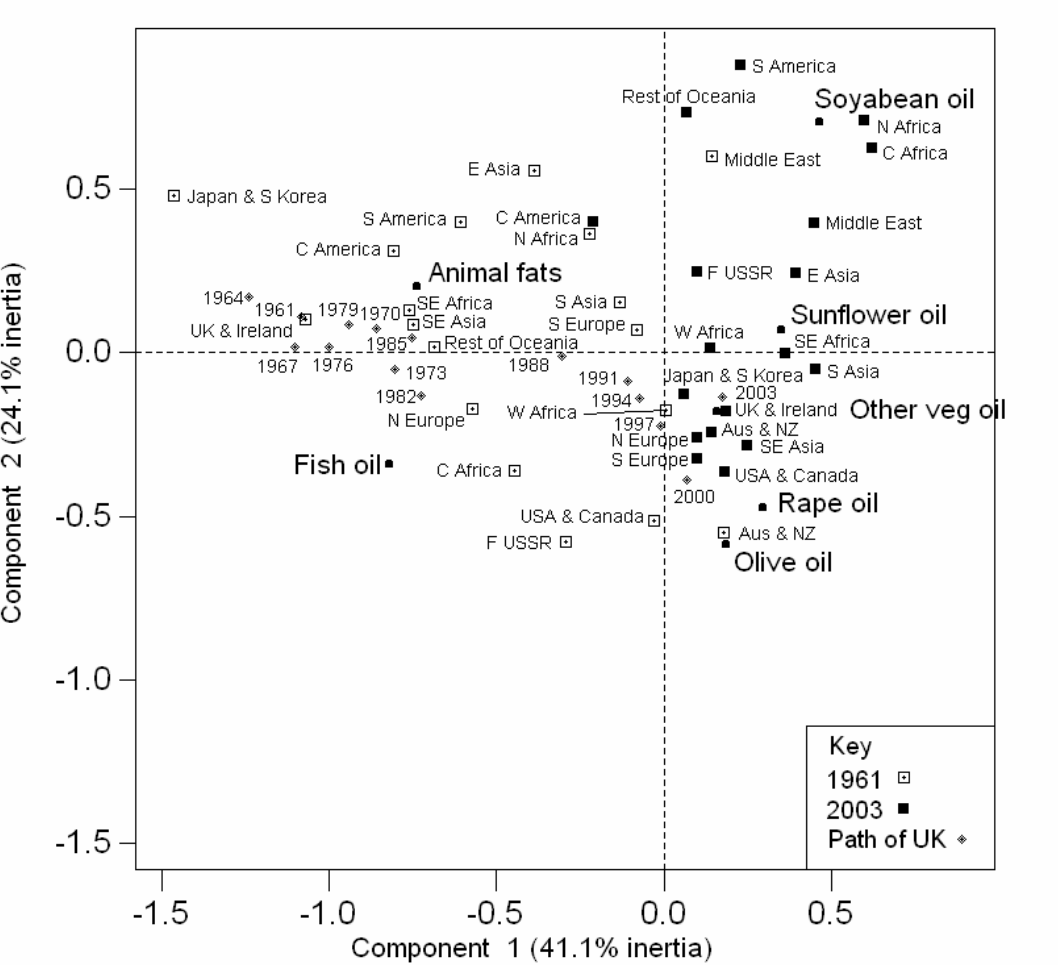
Figure 4: Correspondence analysis – the importation of simplified edible lipid categories by world region in 1961 and